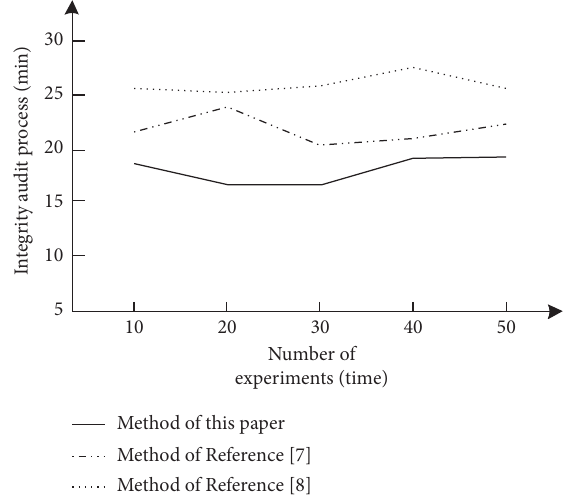
Figure 5: Comparison of the time consumption of the integrity audit process of different methods. Table 2: Comparison of data integrity after the application of different processing methods. Number of experiments/time Method of this paper Method of [7] Method of [8]